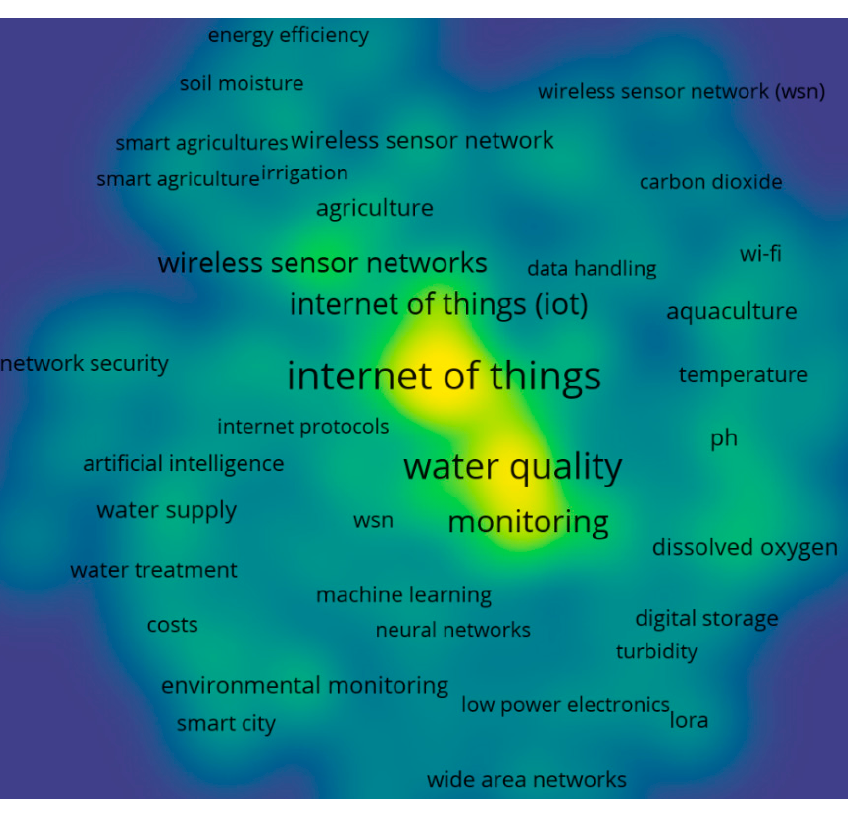
Figure 2. Density analysis of the published papers on IoT for water quality monitoring.